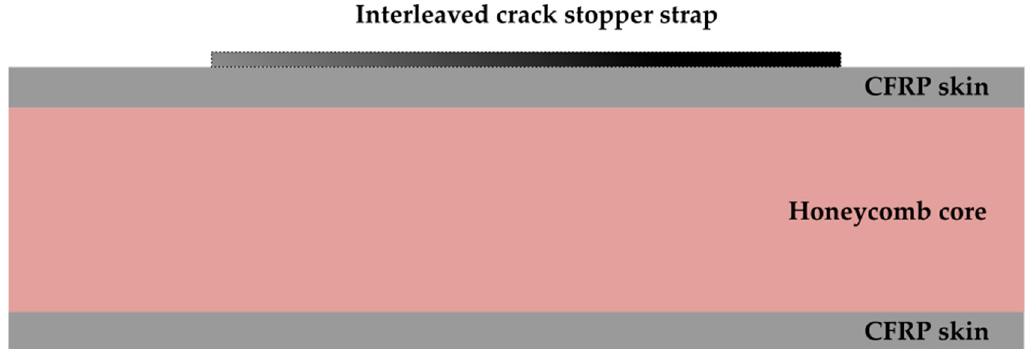
Figure 12. The Interleaved Crack Stopper Strap in honeycomb sandwich panel concept.